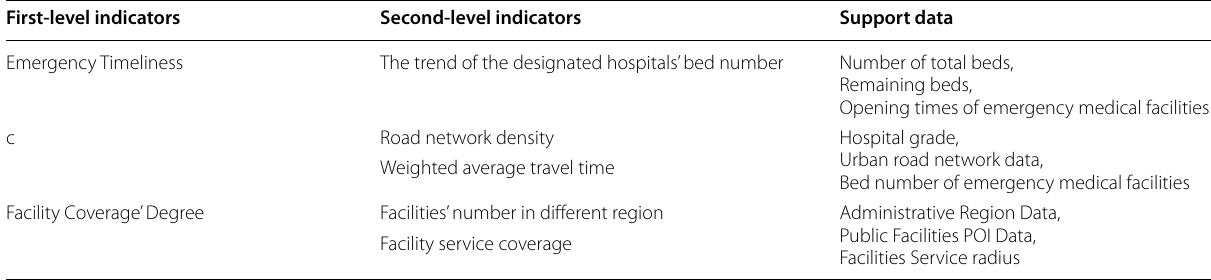
Table 1 Evaluation indicator